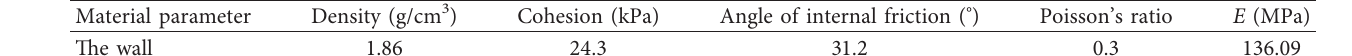
Figure 6: The first three orders of the mode of vibration. (a) First-order transverse bending. (b) Second-order left and right torsion. (c) Third-order vertical bending. Table 2: Physicomechanical parameters of materials [21].